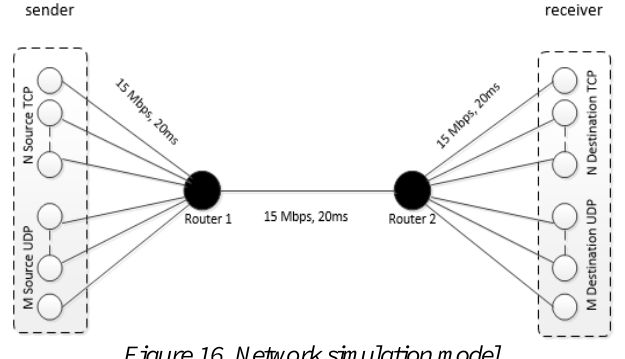
Figure 13. The membership functions of Pr(t) after training